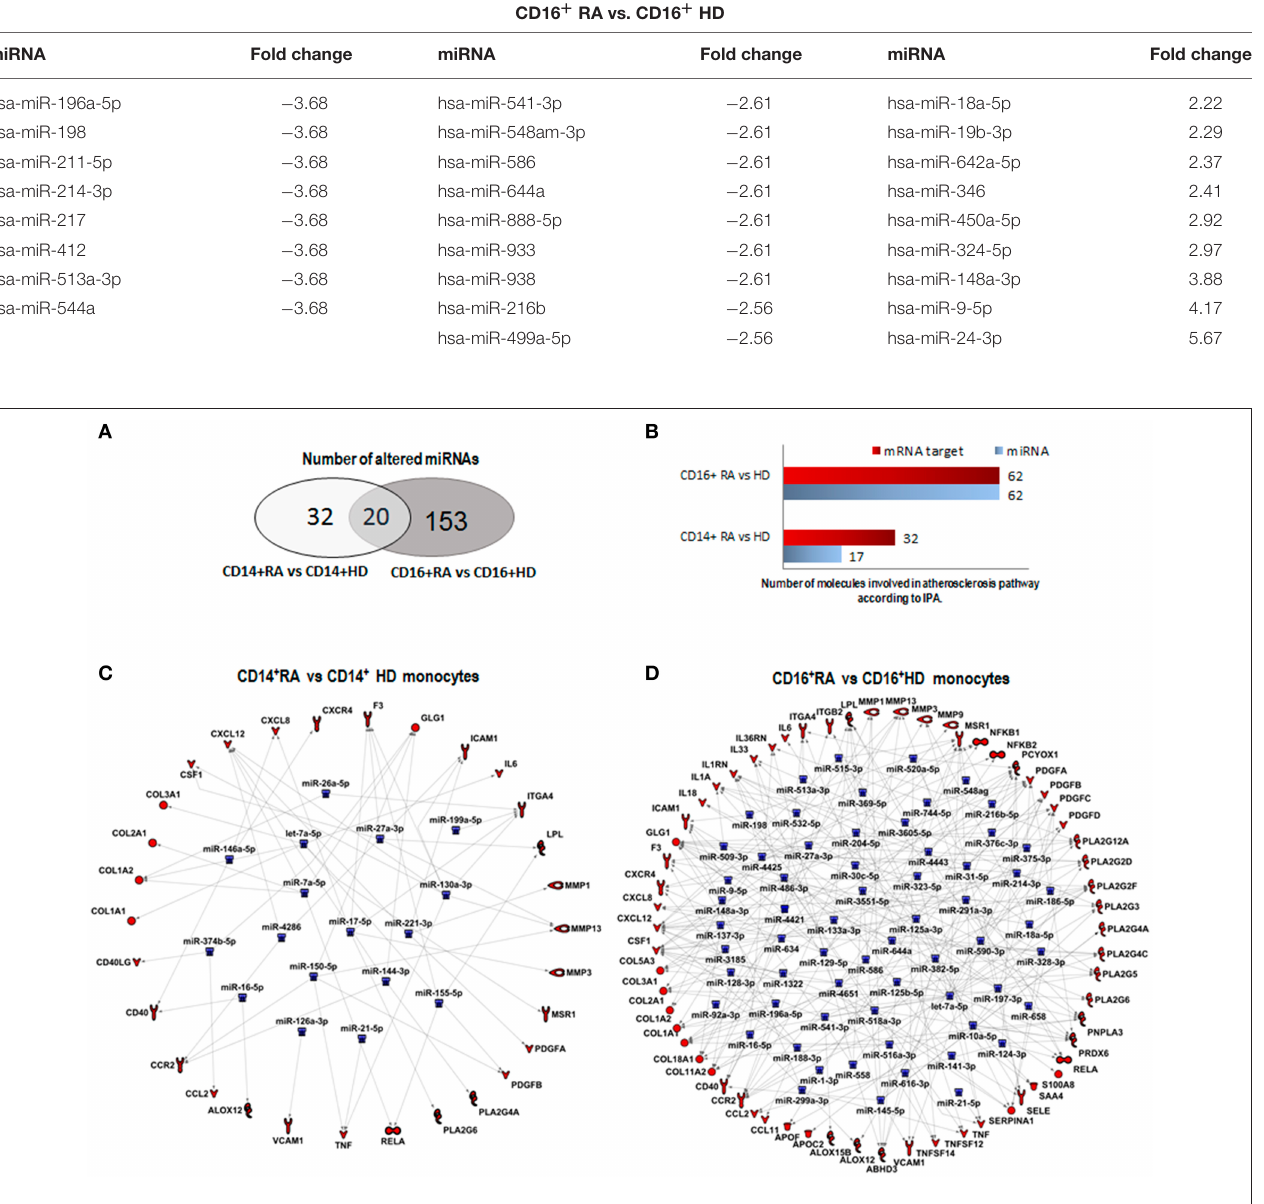
FIGURE 6 | CD16 + monocytes exhibit a prevalence of target mRNAs involved in atherosclerosis. (A) Number of altered microRNAs in CD14 + and CD16 + RA monocytes compared to HDs. 31 were specifically regulated in CD14 + RA monocytes, 153 were specifically regulated in CD16 + RA monocytes and 20 microRNAs were commonly altered in both subtypes in RA patients compared to HDs. (B) Among all the altered microRNAs in CD14 + and CD16 + RA monocytes, number of microRNAs involved in atherosclerosis pathway according to IPA. (C) Putative mRNA targets of the microRNAs altered in CD14 + RA monocytes compared to CD14 + HD monocytes involved in atherosclerosis according to IPA. (D) Putative mRNA targets of the microRNAs altered in CD16 + RA monocytes compared to CD16 + HD monocytes involved in atherosclerosis according to